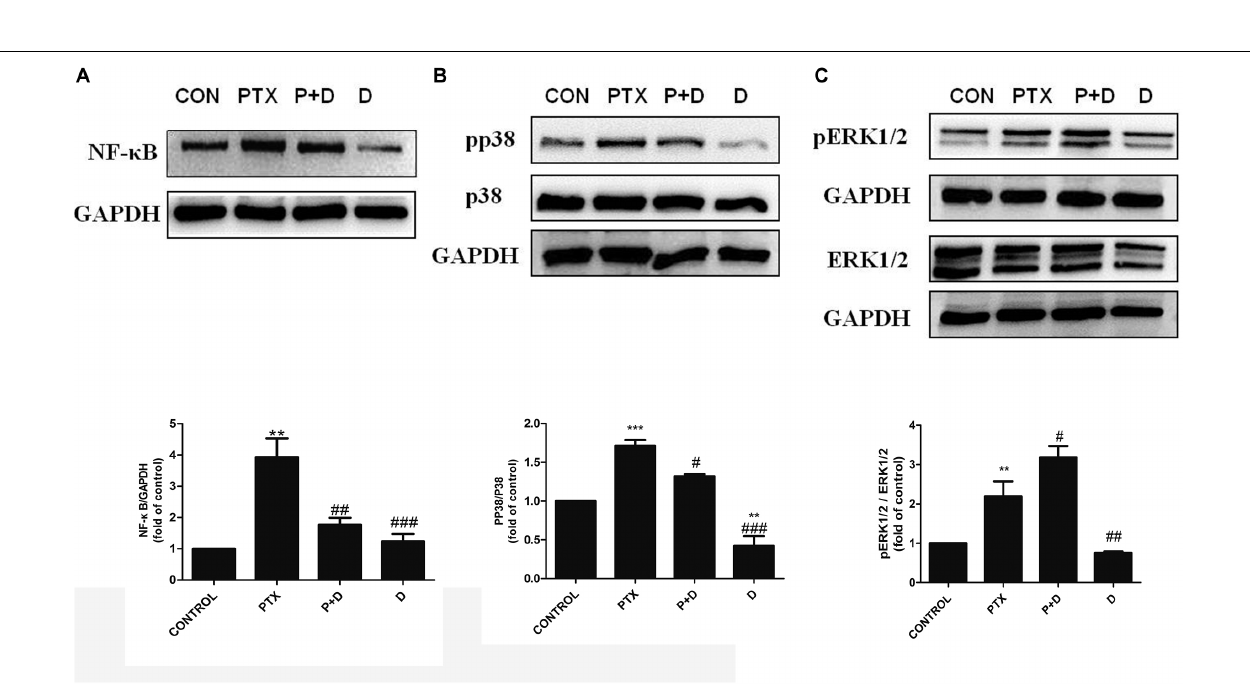
FIGURE 6 | Effect of duloxetine on phosphorylation of p38 MAPK and ERK1/2 expression in the neuropathic mouse DRG following oxaliplatin treatment. (A) Duloxetine significantly decreased the expression of NF- κ B protein in the DRG of OXA-treated mice. (B) Duloxetine significantly decreased the expression of pp38 protein in the DRG of OXA-treated mice. (C) The ratio of pERK1/2 to ERK1/2 expression was not changed significantly following oxaliplatin treatment and duloxetine did not modify p-ERK1/2 expression. ( ∗∗ p < 0.01 vs. control, ## p < 0.01, ### p < 0.001 vs. OXA). The data are presented as the mean ± SEM ( n = 4).